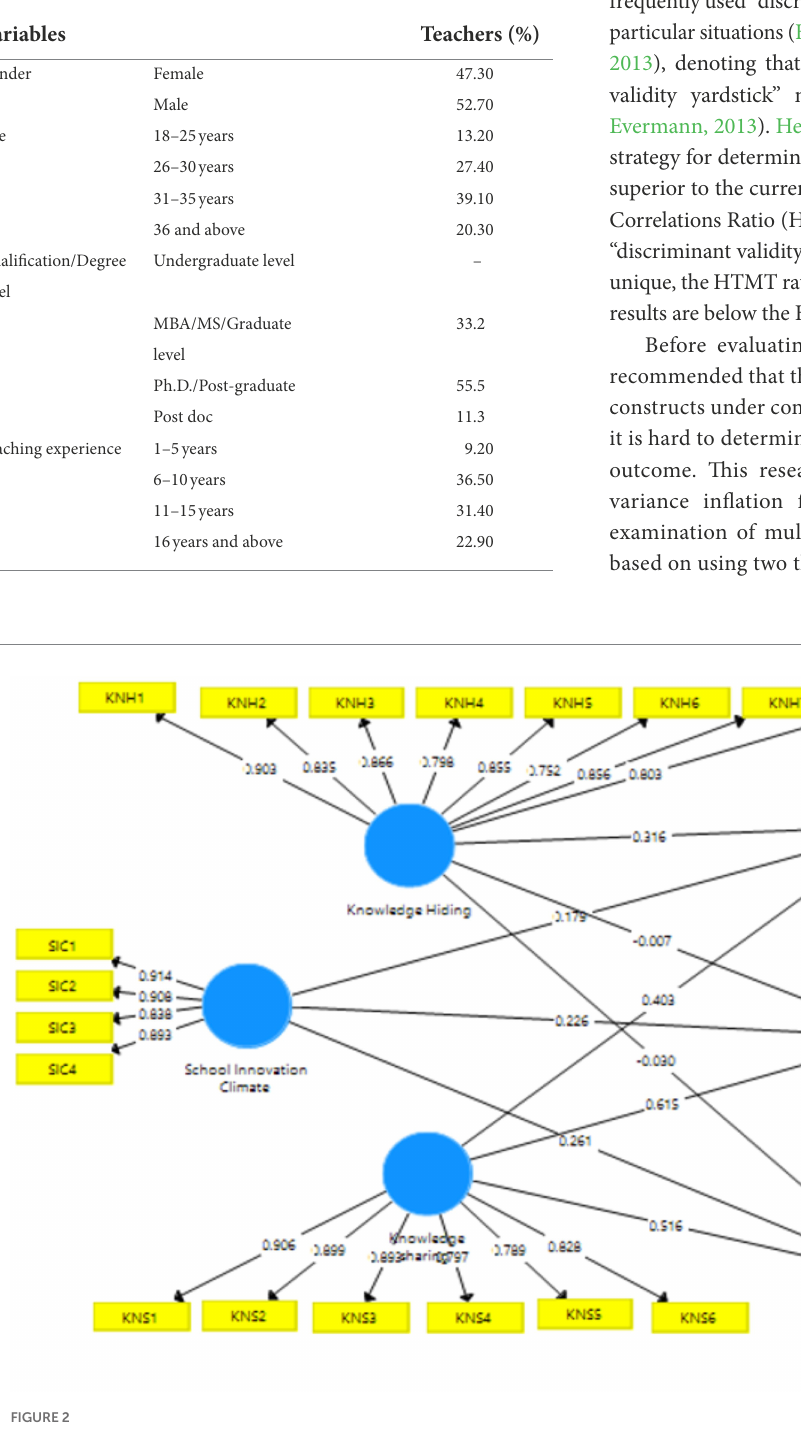
TABLE 1 Respondents’ demographic characteristics.